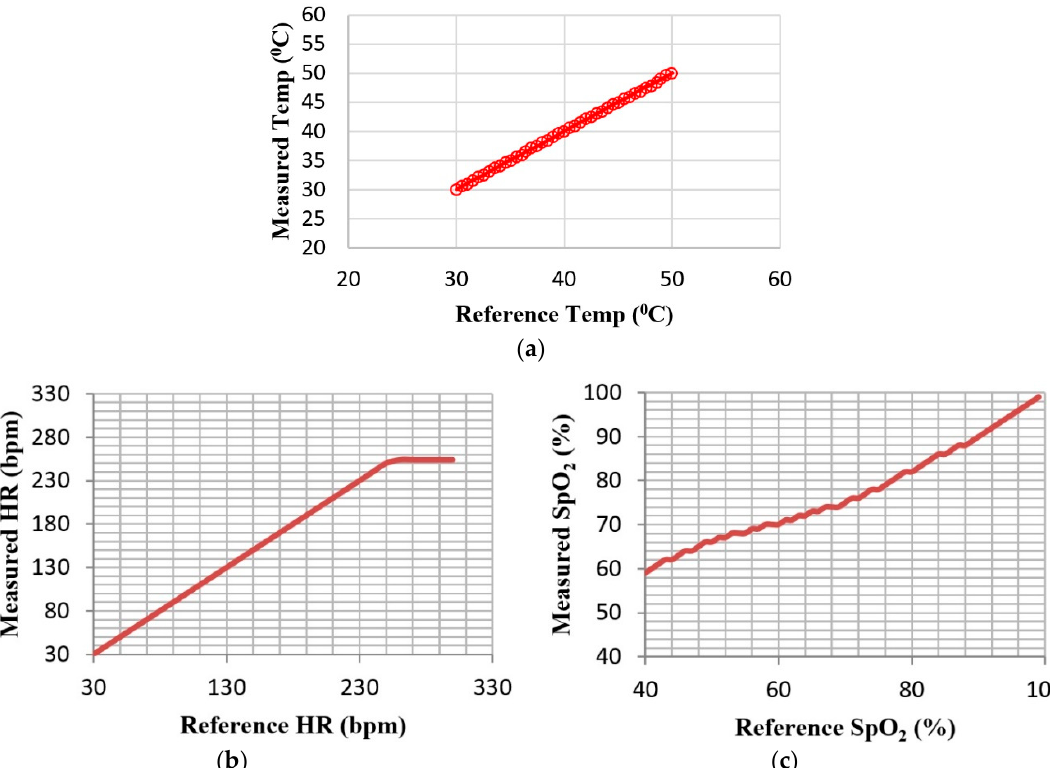
Figure 21. Testing telemonitoring function: ( a ) accuracy of body temperature measurements (°C); ( b ) accuracy of HR measurements (bpm); ( c ) accuracy of SpO 2 measurements (%).